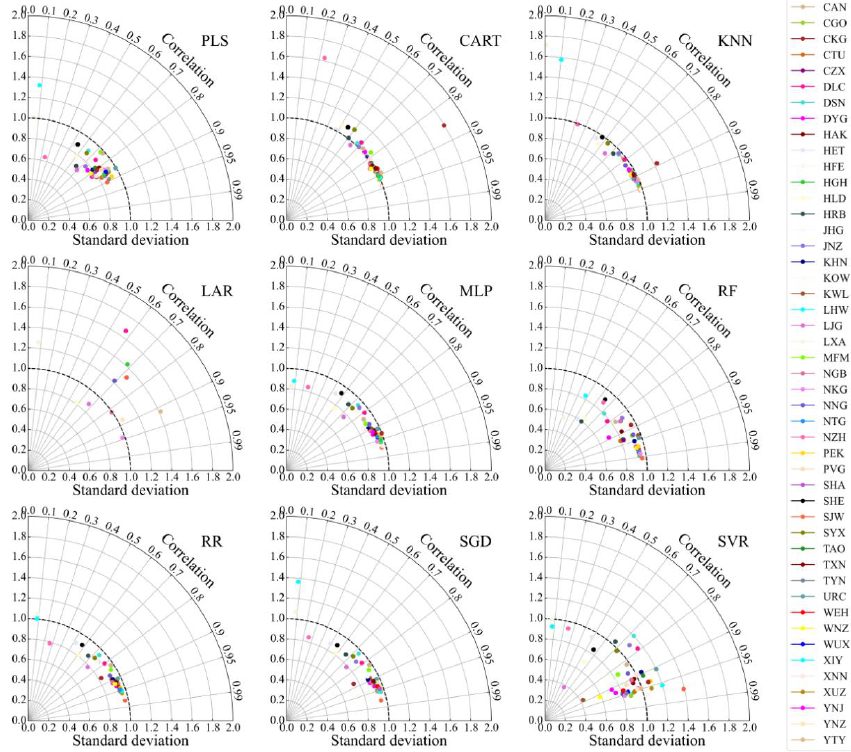
Figure 9. Taylor diagram presents a comparison of the hourly predicted and observed airports visibility in the testing period (2020). The diagram shows the correlation (the arc coordinate) and ratio of the standard deviation between the hourly predicted and observed (Abscissa and ordinate).